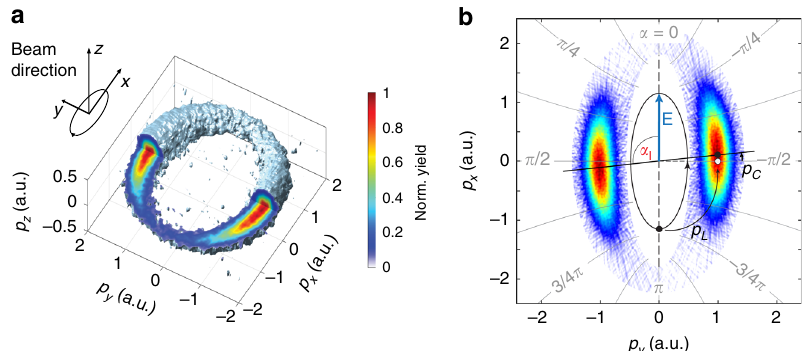
Fig. 2 Momentum distributions from strong- fi eld ionization with angular streaking. a Isosurface of a reconstructed 3D photoelectron momentum distribution (PMD) recorded at an ellipticity of ϵ ¼ 0 : 8 together with a sketch of the polarization ellipse and the beam direction. b Polarization plane PMD for an ellipticity of ϵ = 0.5 visualizing the de fi nition of elliptical coordinates and the streaking angle α . Superimposed is the illustration of the effect of the parent – ion interaction onto an outgoing electron ionized at the peak of the electric fi eld, as indicated by the polarization ellipse in black. The fi nal momentum of the photoelectron gains in addition to the momentum p the interaction with the parent ion mostly in the direction of the instantaneous electric fi eld. The angle α ionization